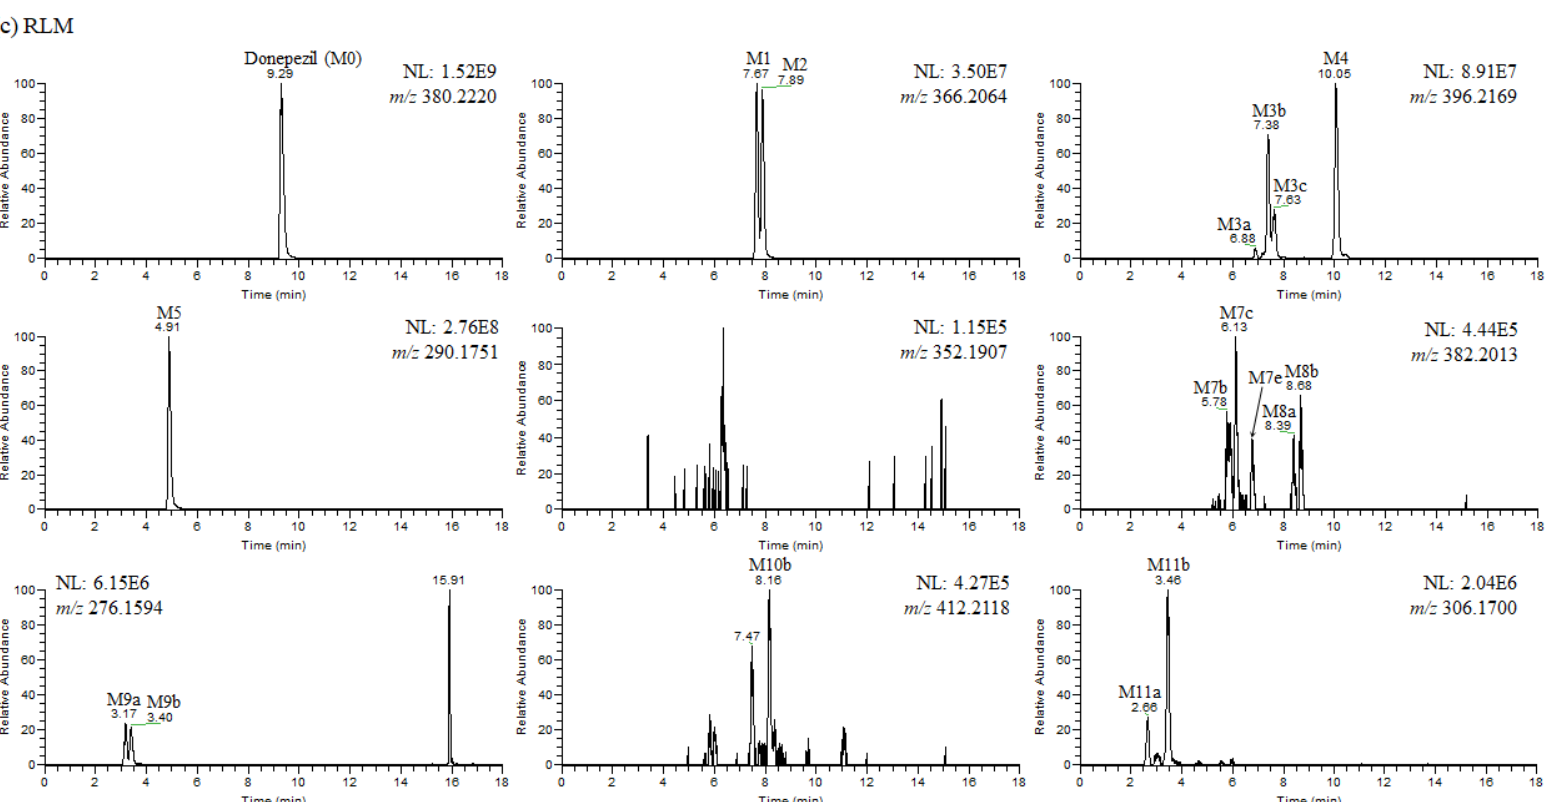
Figure 4. ( a ) Representative extracted ion chromatograms of donepezil and its metabolites obtained from the liquid chromatography–high resolution mass spectrometry analysis of human liver microsomes (HLM) incubation mixtures of donepezil in the presence of nicotineamide adenine dinucleotide phosphate reduced form (1 h, 37 ◦ C). NL stands for normalization level, which describes the intensity of the highest peak in each chromatogram. ( b ) Representative extracted ion chromatograms of donepezil and its metabolites obtained from the liquid chromatography–high resolution mass spectrometry analysis of mouse liver microsomes (MLM) incubation mixtures of donepezil in the presence of nicotineamide adenine dinucleotide phosphate reduced form (1 h, 37 ◦ C). NL stands for normalization level, which describes the intensity of the highest peak in each chromatogram. ( c ) Representative extracted ion chromatograms of donepezil and its metabolites obtained from the liquid chromatography–high resolution mass spectrometry analysis of rat liver microsomes (RLM) incubation mixtures of donepezil in the presence of nicotineamide adenine dinucleotide phosphate reduced form (1 h, 37 ◦ C). NL stands for normalization level, which describes the intensity of the highest peak in each